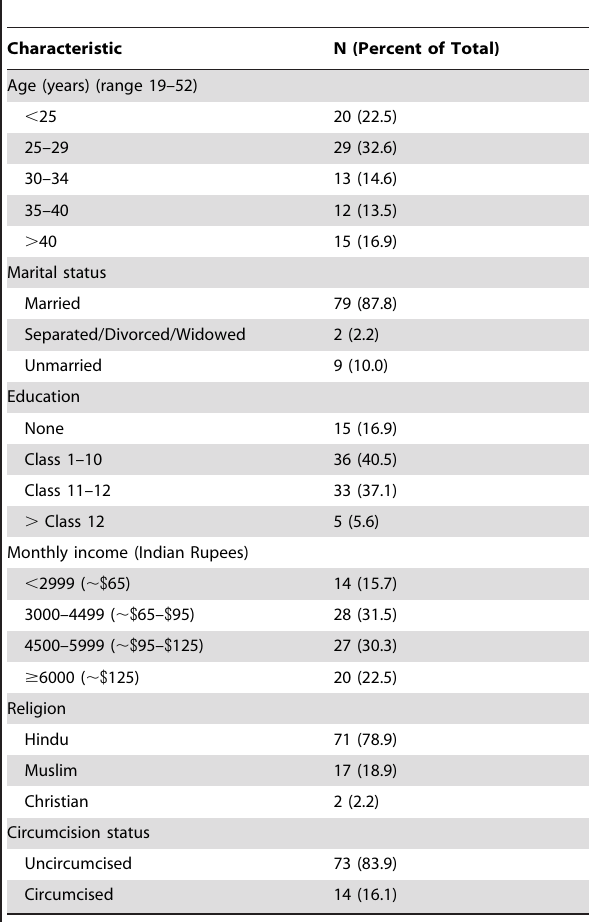
Table 1. Sociodemographic characteristics of truck-drivers in sample (n